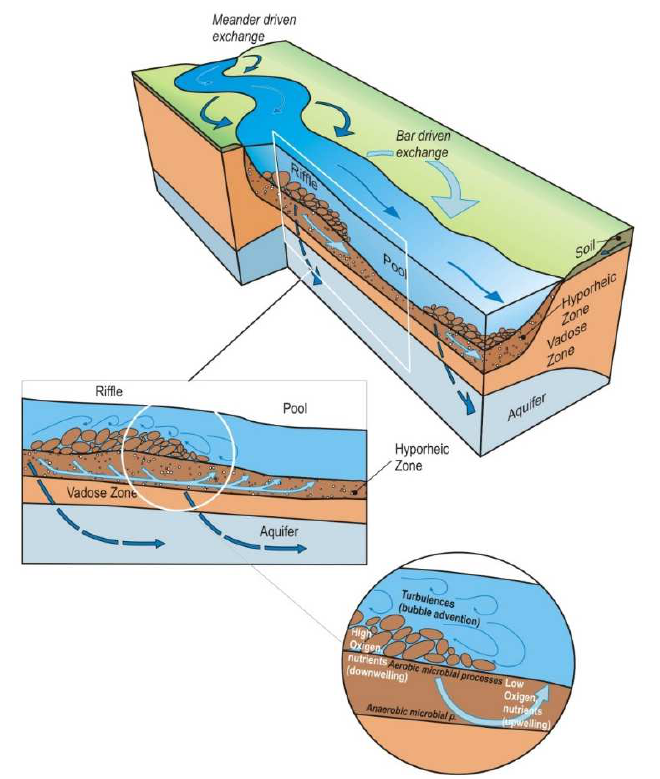
Figure 1. Hyporheic reach—scale exchange pattern associated with ripples, bars, and meanders, adapted from [14].